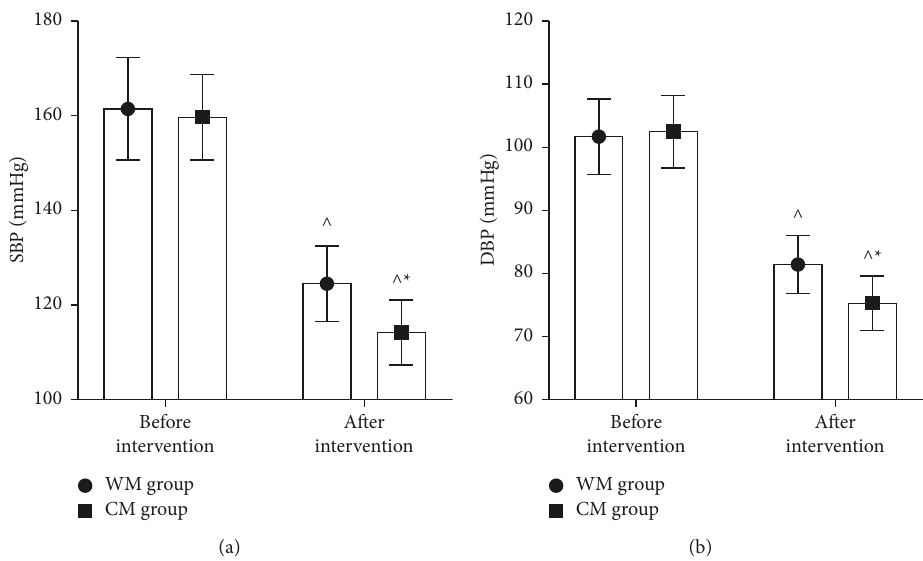
Figure 1: Comparison of SBP and DBP levels in both groups. (a) SBP level. (b) DBP levels. Compared with the same group before